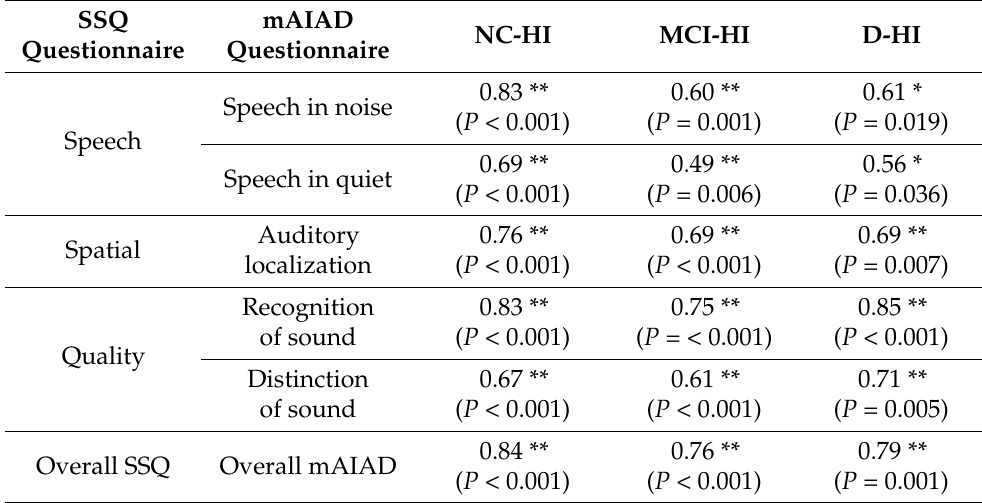
Table 2. Pearson correlations between self-reported hearing handicap scores from the SSQ and mAIAD